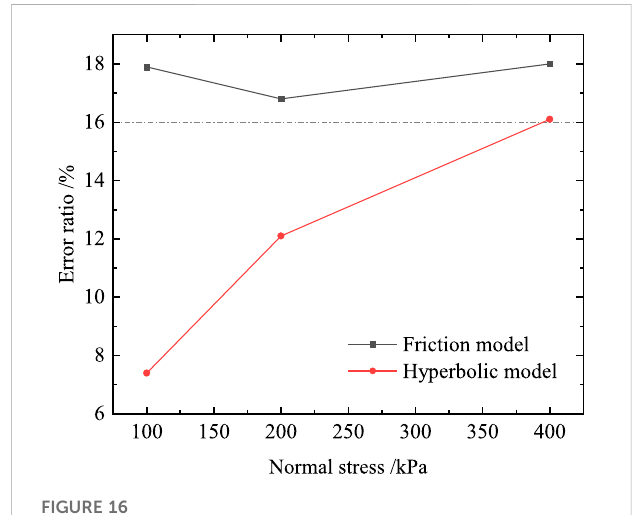
FIGURE 16 The error of different calculation models compared with direct shear test.